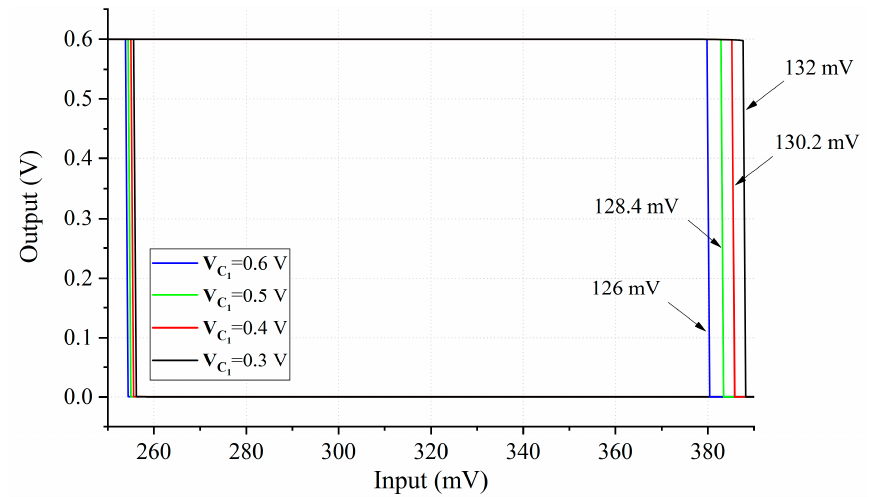
Figure 9. Dependence of the threshold voltages on the V c1 variation. V in+ is swept from 0 to 0.6 V and vice versa, while V in − is set to 0.3 V.